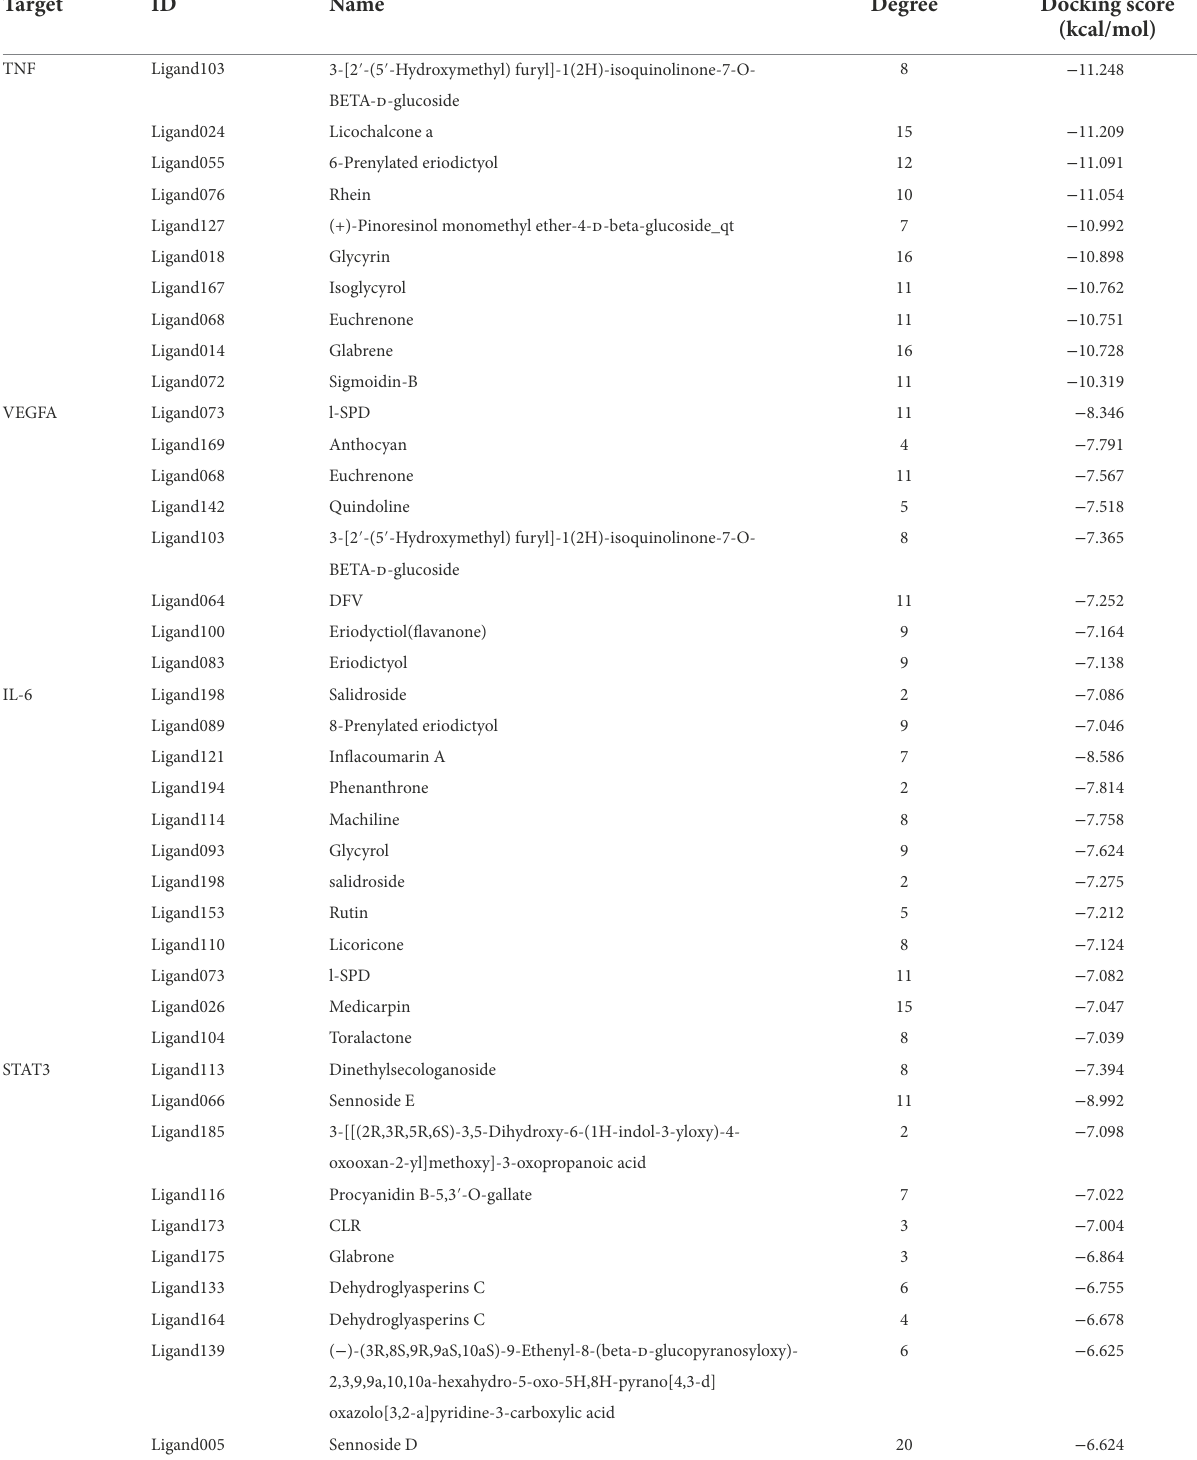
TABLE 2 The docking results for AKT1, STAT3, TLR4, TNF, VEGFA, and IL6 with top 10 compound.